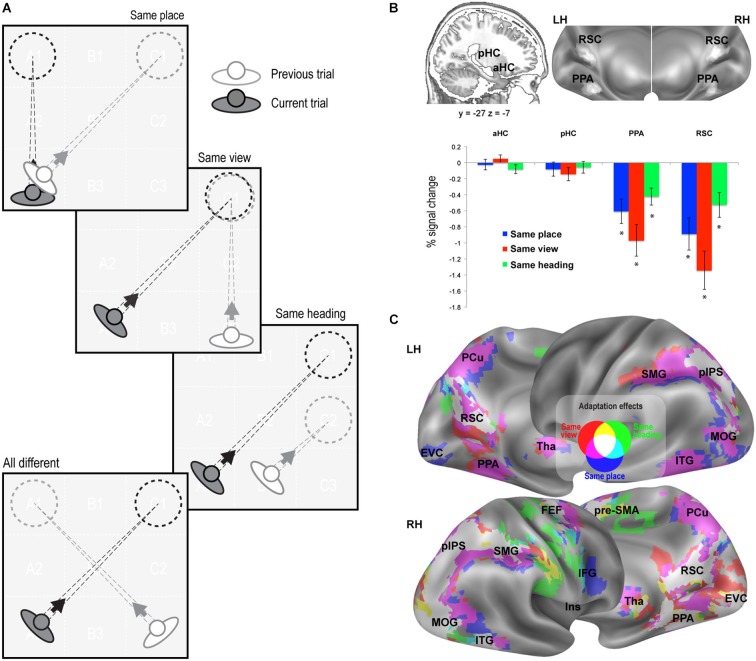
fMR adaptation results. (A) Schematic illustration of the rationale of the adaptation analysis. Each trial (current trial) was labeled according to its relationship with the previous trial (same place, same view, same heading, or all different). (B) Adaptation effects in predefined ROIs. Top: Anatomical localization of the anterior (aHC) and posterior hippocampus (pHC) for one sagittal slice (left) and superposition of individually-defined parahippocampal place area (PPA) and retrosplenial complex (RSC) on the medial/inferior view of the cortical surface of the left (LH) and right (RH) hemispheres (right). Bottom: Plots show adaptation effects for place, view, heading, i.e., reduction of estimated BOLD signal in same-place, same-view, and same-heading trials compared to all-different trials. * p < 0.001. (C) Whole-brain adaptation effects. Voxels showing significant response attenuation for same-place (blue), same-view (red), and same-heading trials (green) as compared to all-different trials, are superimposed on reconstructions of the lateral and medial surfaces of the left (LH) and right (RH) hemispheres.